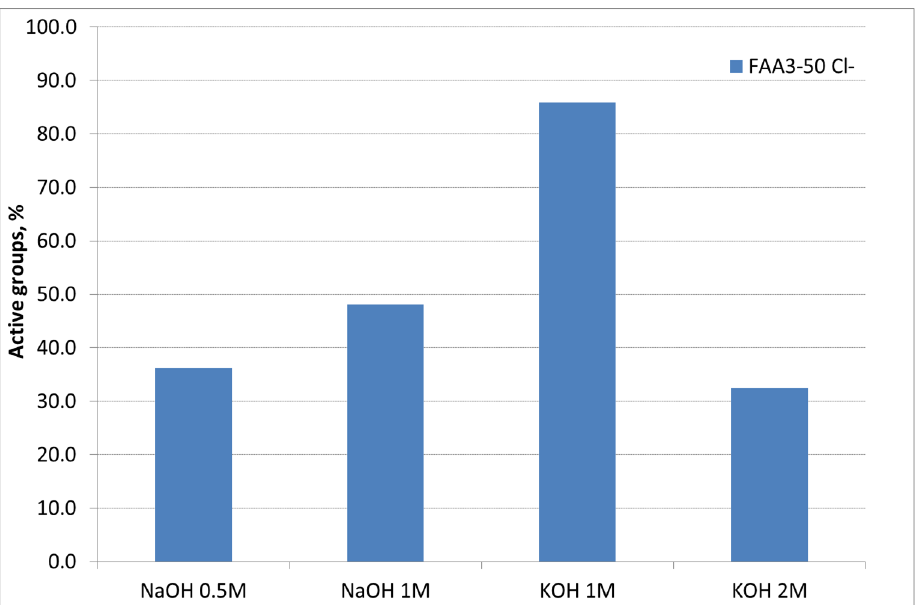
Figure 2. Influence of base type and concentration during the ion-exchange process.